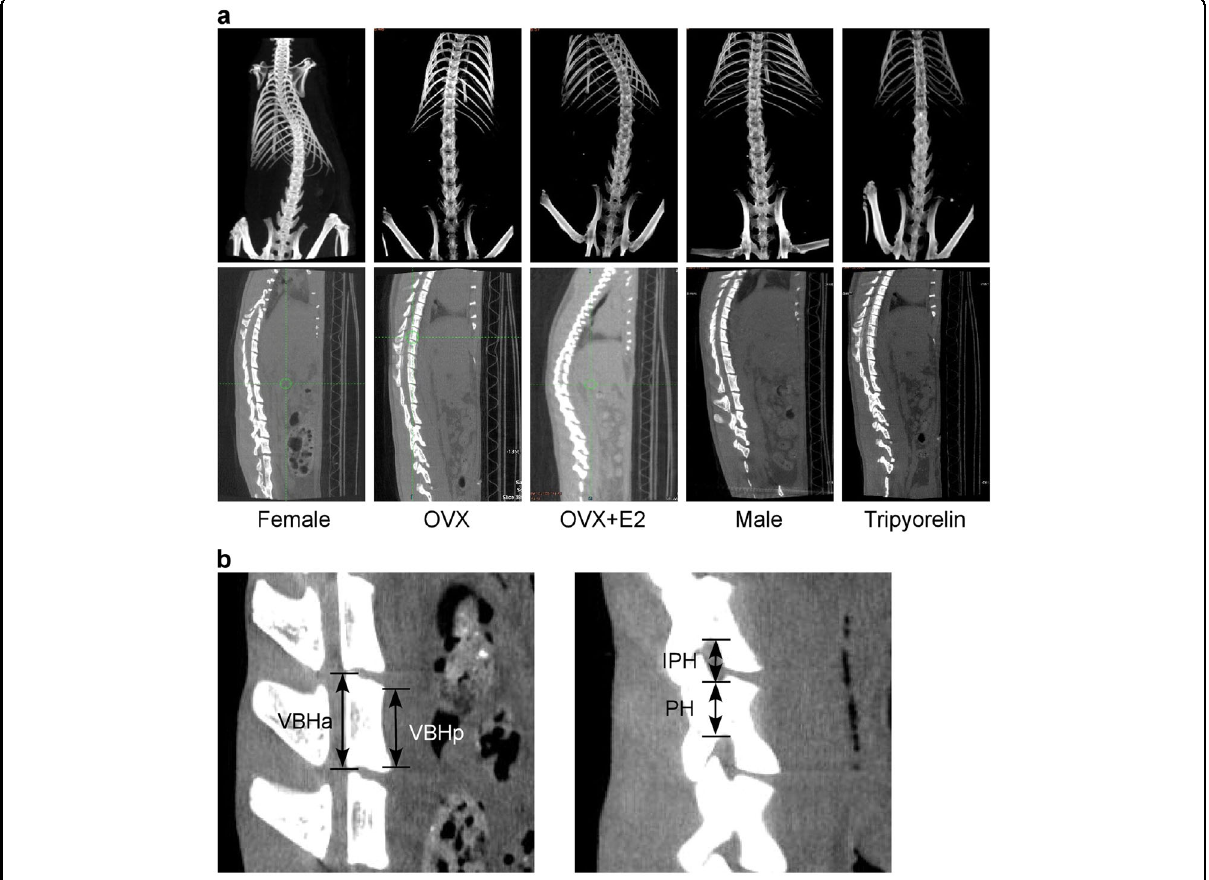
Fig. 2 The spine CT scans of the four groups. a Coronal CT scans of the four groups recorded at 15 th week after surgery. b Sagittal CT scan showing how the measurements of the vertebral body (VBHa and VBHp) and the pedicle (PH and IPH) were